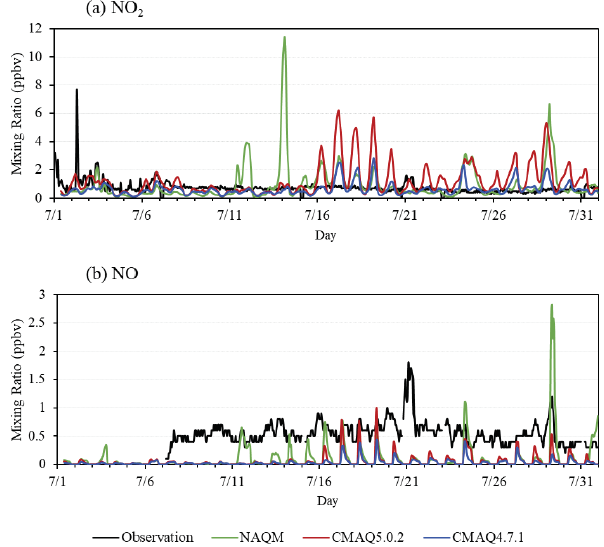
Figure 5. (a) Mixing ratios of NO 2 ∗ by observation, NO 2 by NAQM, CMAQ v.5.0.2, and CMAQ v. 4.7.1 at Oki in July 2010. (b) Same as (a) but for NO. The sharp peak of NO 2 on 2 July would be an artifact or influence of accidental local pollution (see